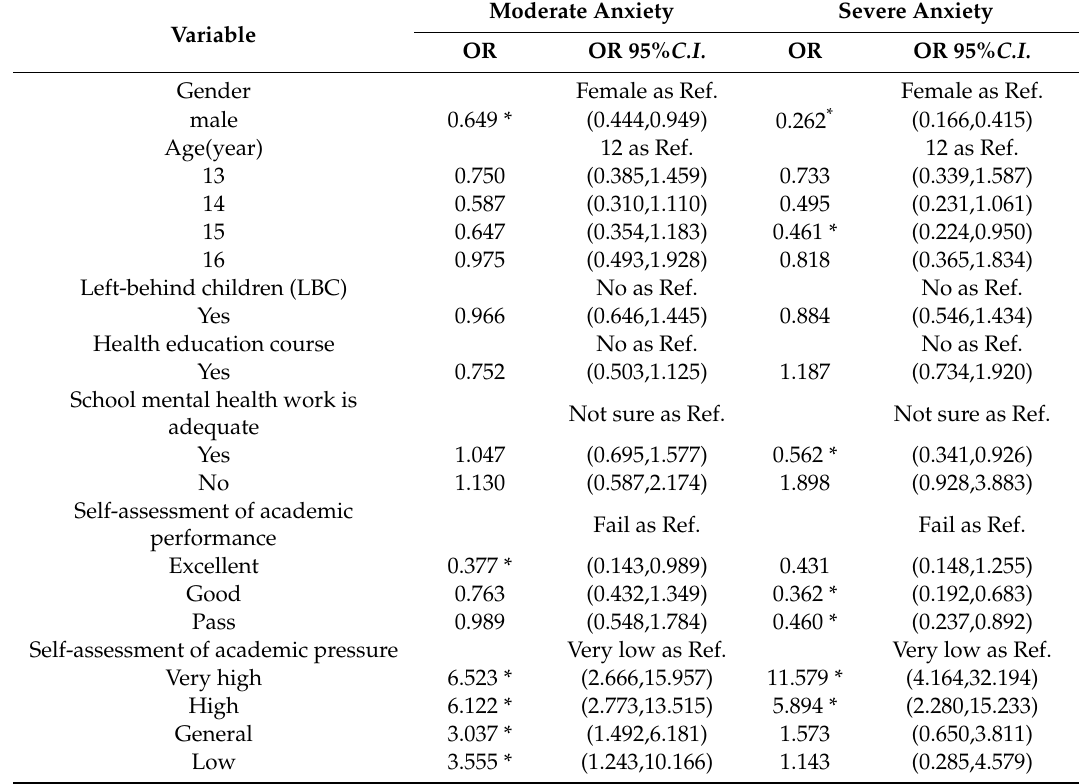
Table 4. The multifactor analysis of anxiety of junior high school students in the rural areas of Jiangxi Province by logistic